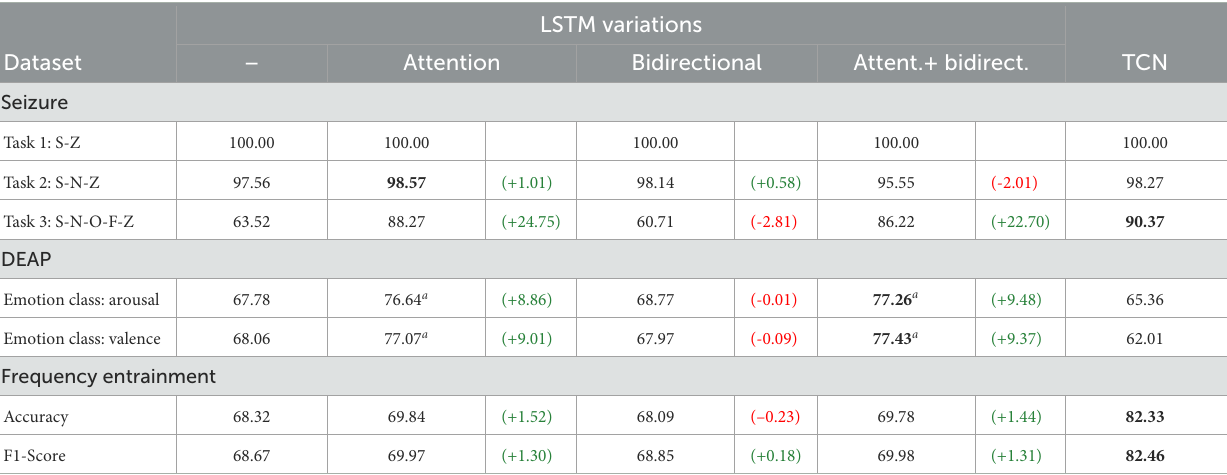
TABLE 7 Accuracy (%) for different LSTM variations compared to the TCN.